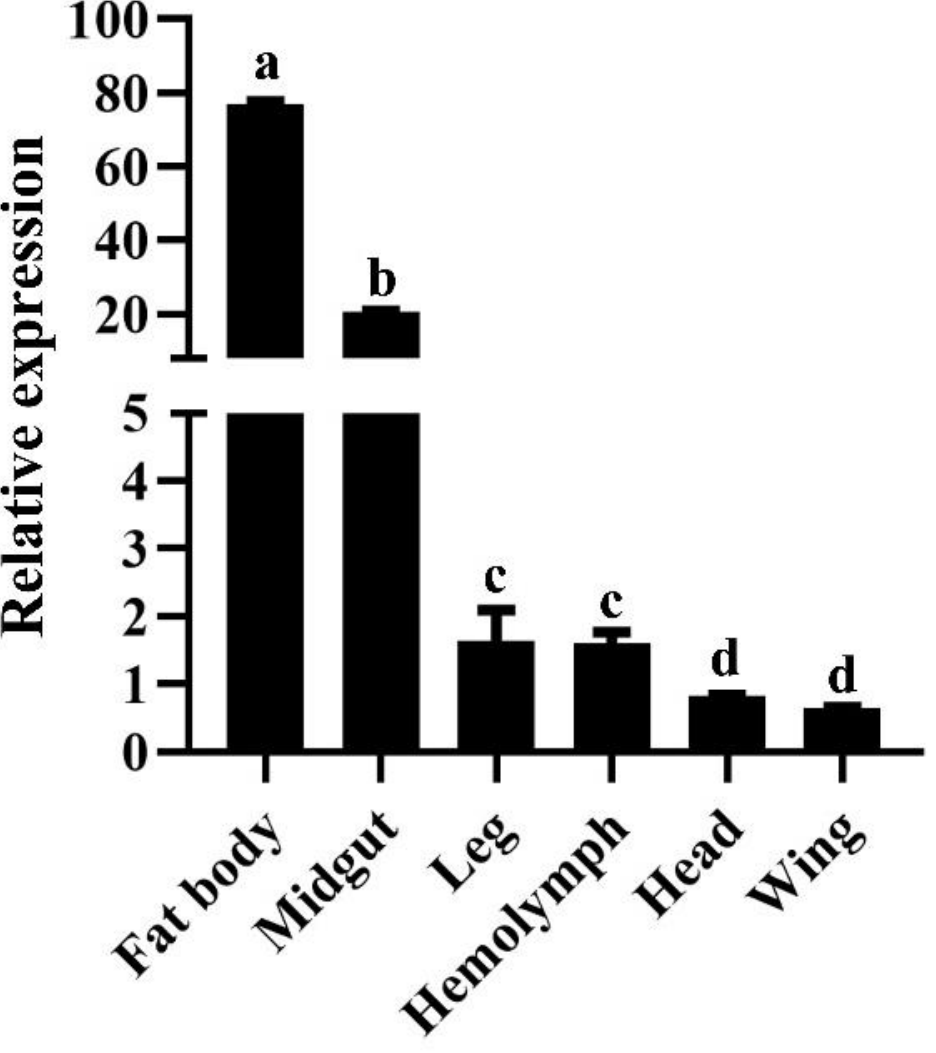
Figure 4. Relative expression levels of LoTRE1 in different tissues of adult L. oryzophilus . All data obtained were expressed as the means ± standard deviations of three replicates and were tested using a one-way ANOVA and t tests using SPSS 22.0. The significant changes are indicated by different letters above the bars. ( p < 0.05).